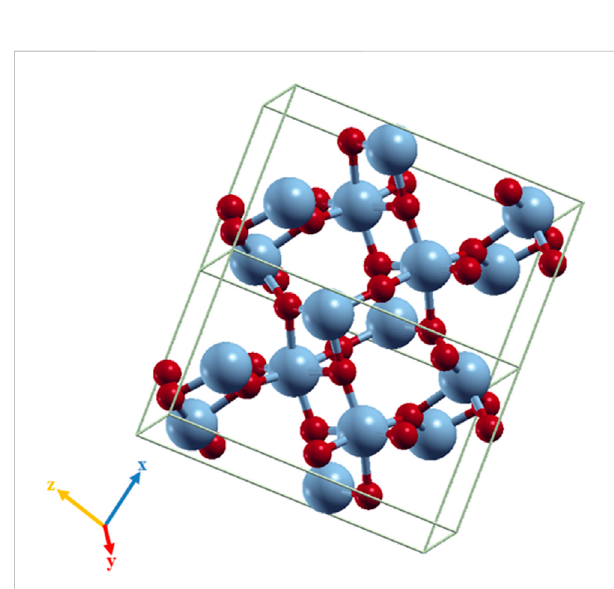
FIGURE 2 Octahedra frameworks (VO 6 )in the VO 2 (M) nanostructure. Color code in the ball and stick model: V = blue and O =